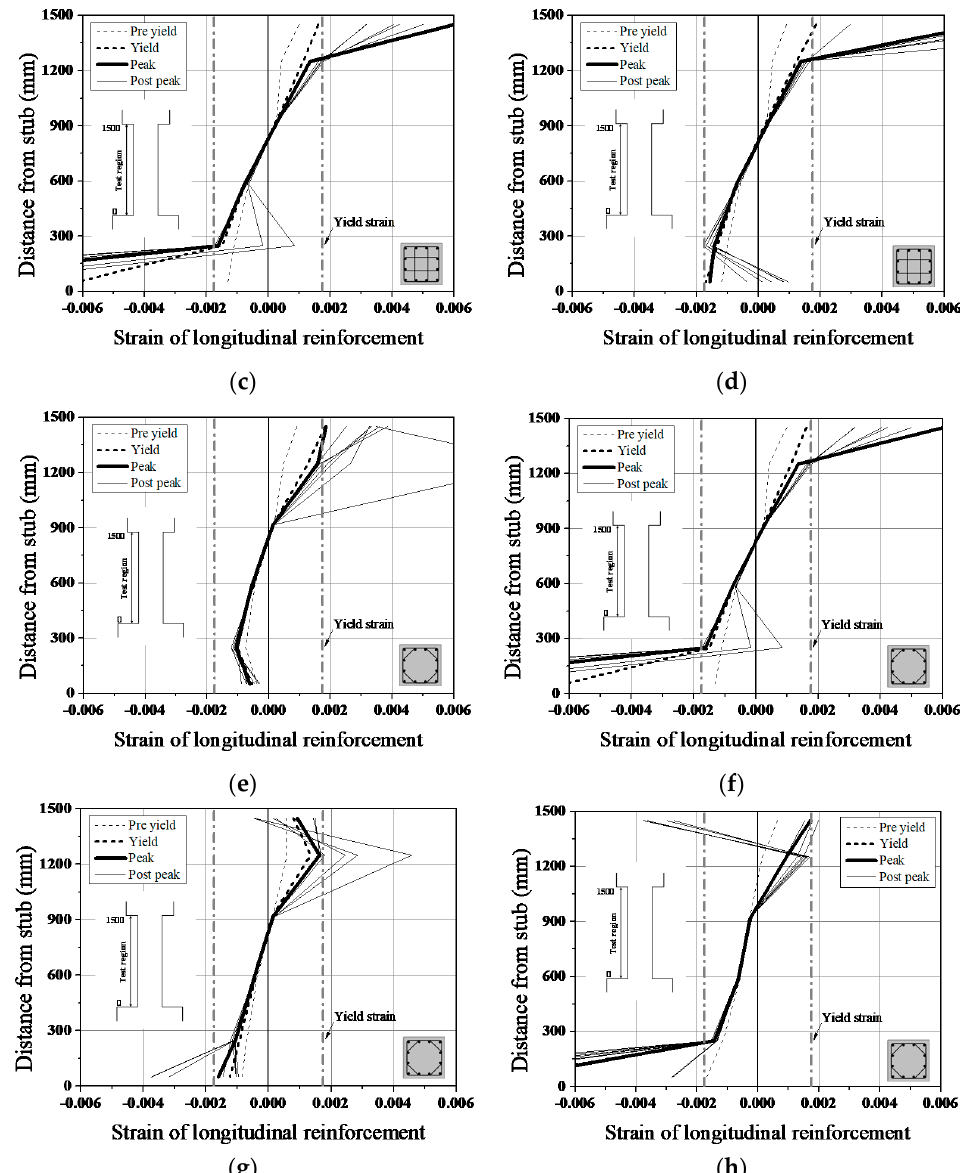
Figure 7. Strain distributions of longitudinal reinforcement: ( a ) NH20; ( b ) NH30; ( c ) UH20; ( d ) UH30; ( e ) NS20; ( f ) NS30; ( g ) US20; ( h ) US30.